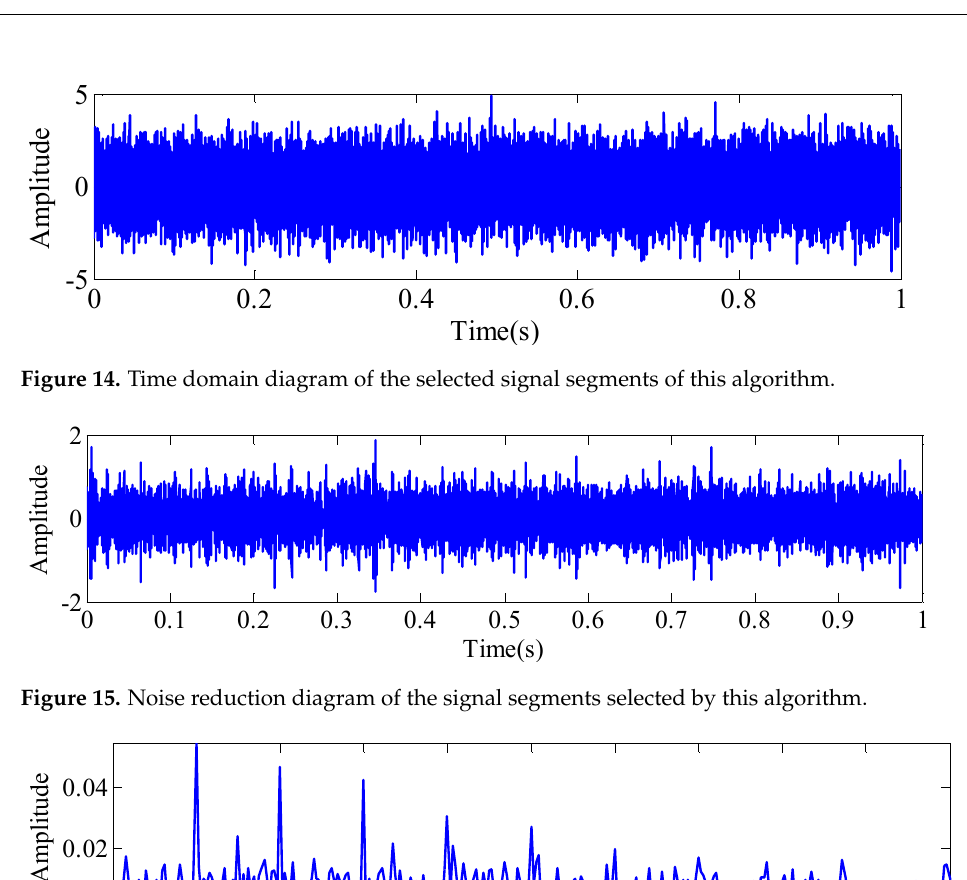
Table 2. The kurtosis values of segment signals.